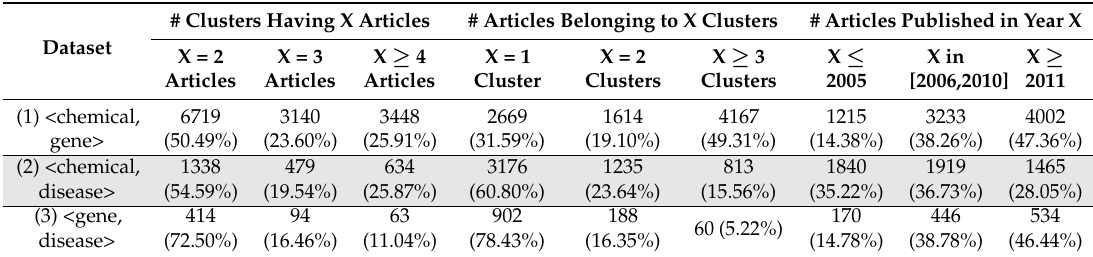
Table 1. Statistical characteristics of the three datasets in the experiment.